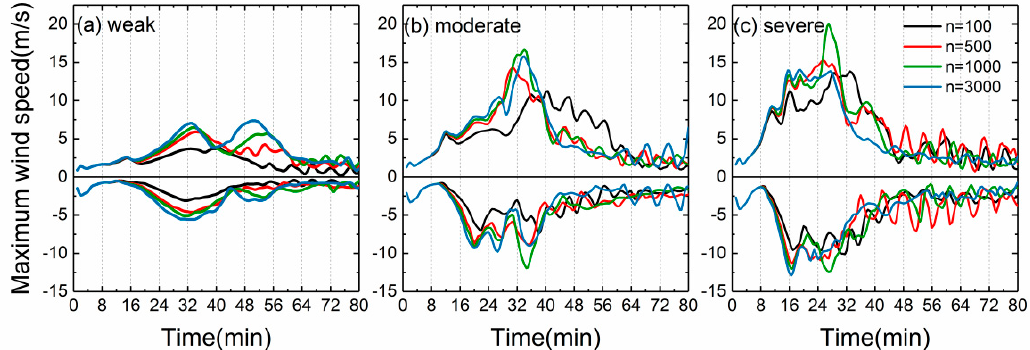
Figure 2. The time evolution of maximum and minimum vertical velocities present: ( a ) in weak thundercloud, ( b ) in moderate thundercloud, ( c ) in severe thundercloud.